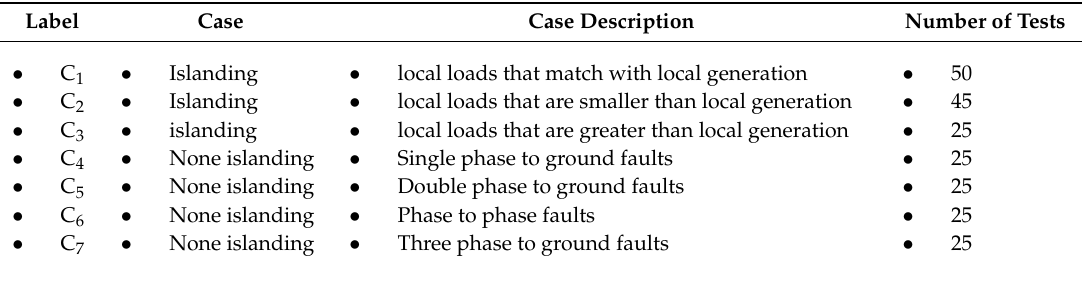
Table 1. Simulated